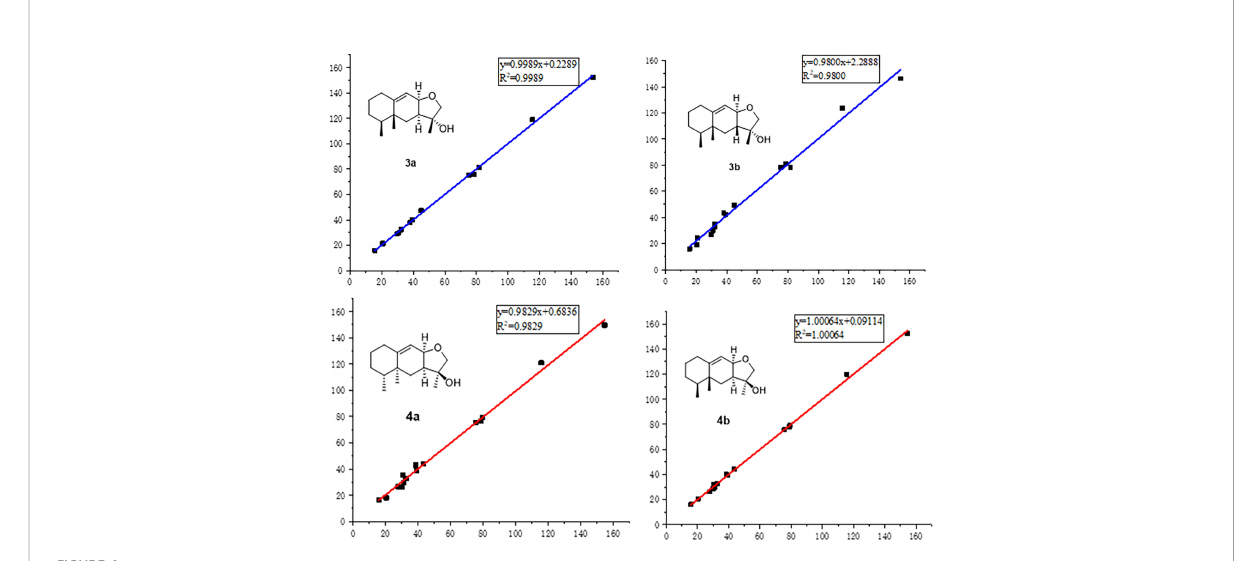
FIGURE 4 Regression analyses of experimental and calculated 13 C NMR chemical shifts for 3a , 3b , 4a , and 4b .